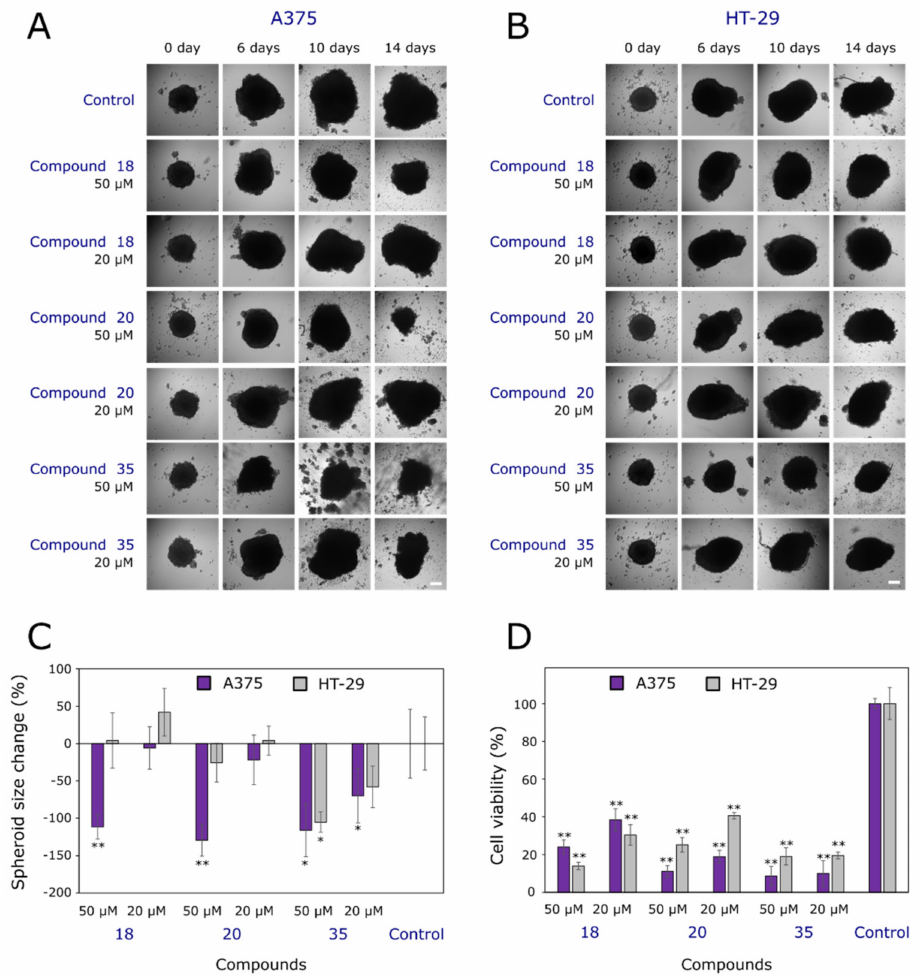
Figure 4. Effects of compounds 18 , 20 and 35 on 3D cell cultures. ( A ) Photos of human melanoma (A375) tumor spheroids at different periods of the experiment. ( B ) Photos of human colon adeno- carcinoma (HT-29) tumor spheroids at different periods of the experiment. ( C ) Spheroid size at the end of the experiment. ( D ) Cell viability in A375 and HT-29 spheroids. Single asterisks (*) indicate p < 0.05, and pairs (**) indicate p < 0.01 compared to the control (untreated spheroids). Scale bars indicate 100 µ